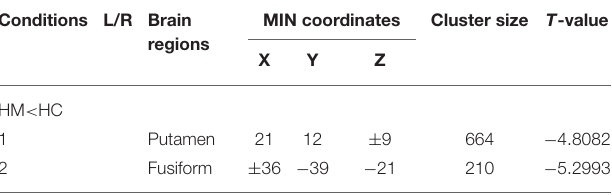
TABLE 2 | Different voxel-mirrored homotopic connectivity (VMHC) values of brain areas between the HM and HC groups (voxel level P < 0.01, Gaussian random field, GRF,